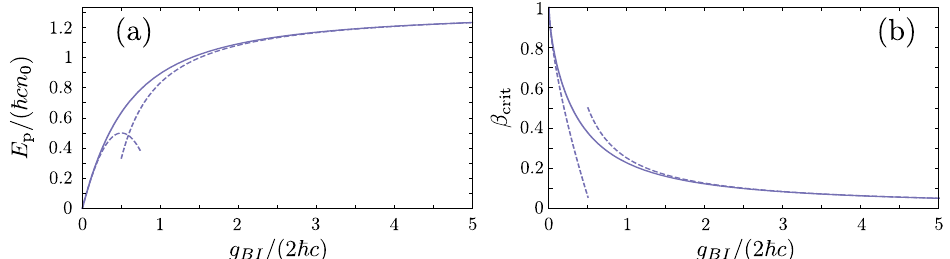
Figure 1. Analytical predictions for the energy and critical velocity of the Bose polaron within GA. ( a ) Polaron energy, E p [Equation (12)] and ( b ) critical velocity of the polaronic solution, β crit , [Equation (14)] for varying bath-impurity interaction strength, g BI . In both cases the solid lines indicate the exact results while the dashed lines correspond to weak (leftmost line), O (cid:16) (cid:17) 2 2¯ hc strong (rightmost line), O , asymptotic Taylor g BI